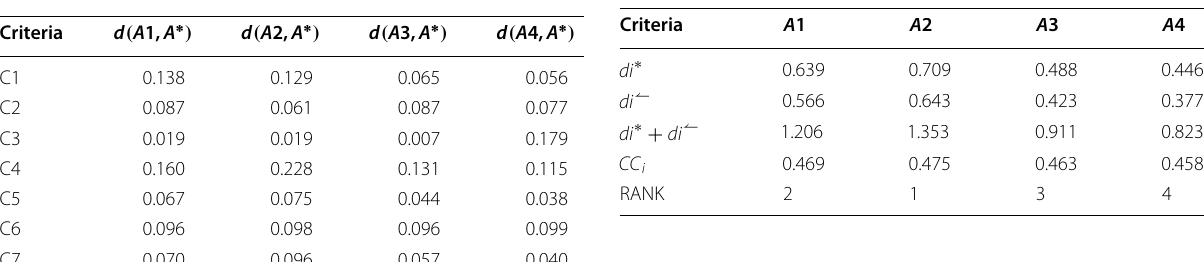
Table 14 Calculations of the di ∗ , di ↼ and closeness